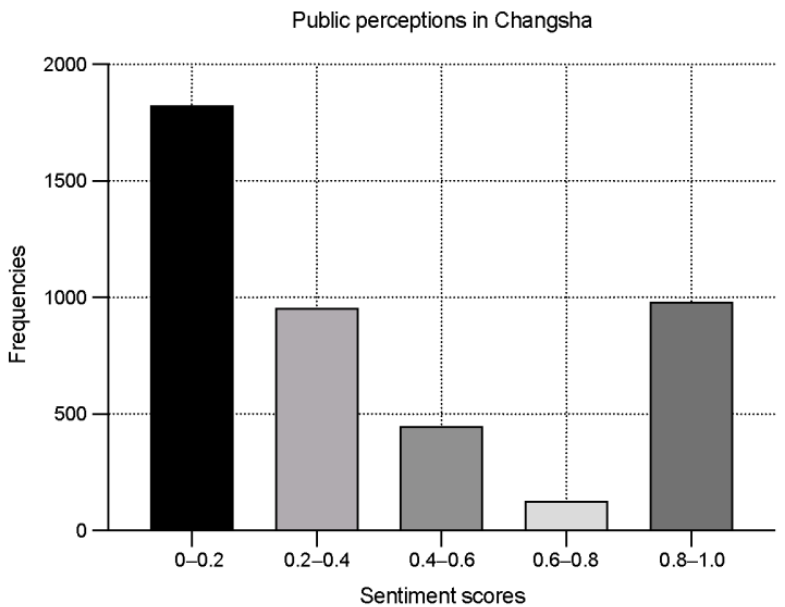
Figure 3. Sentiment score of UGSs in Changsha